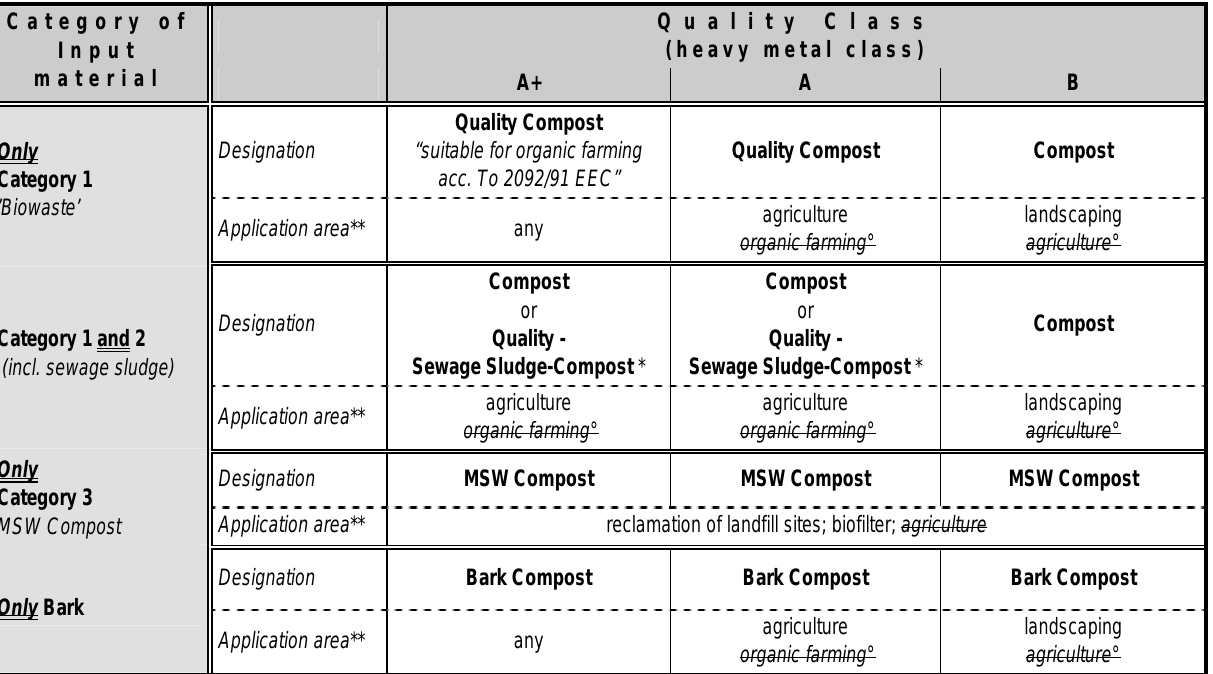
Table 17: System of compost denomination, quality classes, input category and area of